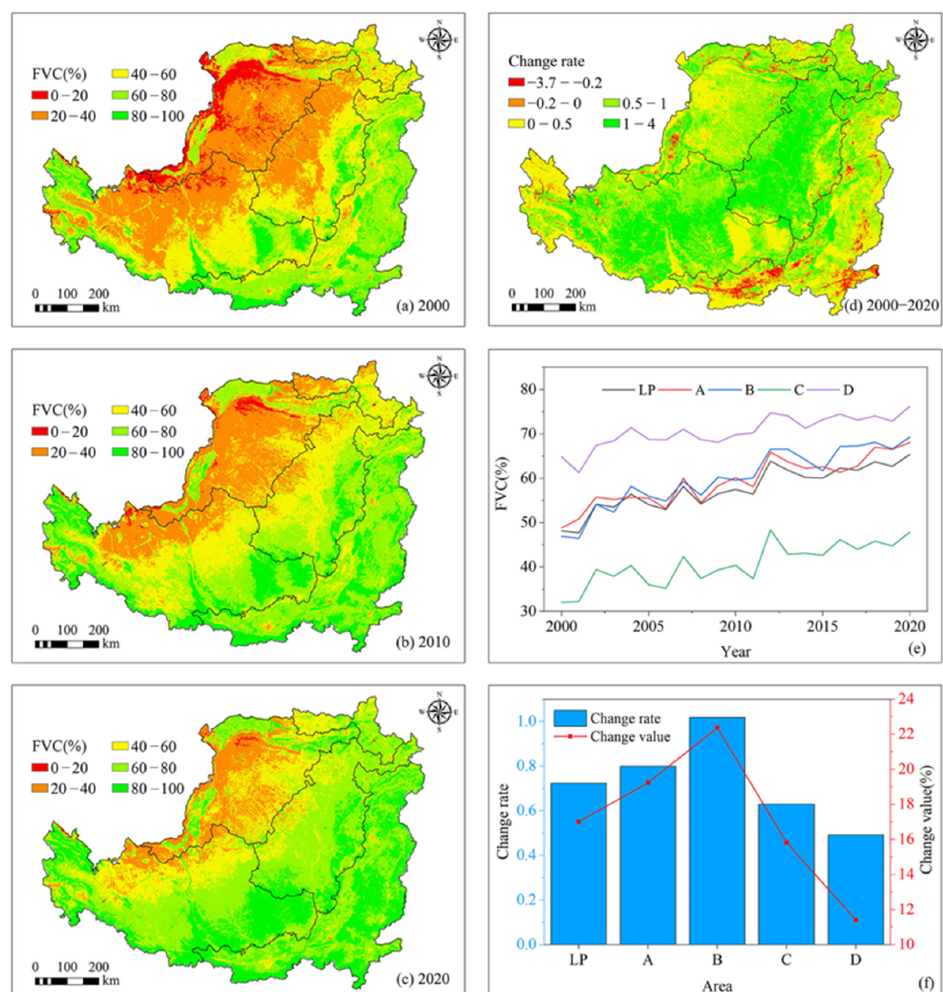
Figure 3. Characteristics of FVC in the LP from 2000 to 2020: ( a ) spatial distribution of FVC in 2000; ( b ) spatial distribution of FVC in 2010; ( c ) spatial distribution of FVC in 2020; ( d ) FVC spatial varia- tion trend; ( e ) interannual variation in FVC; ( f ) FVC change rate and change value. Table 2. FVC of different grades on the LP from 2000 to 2020.